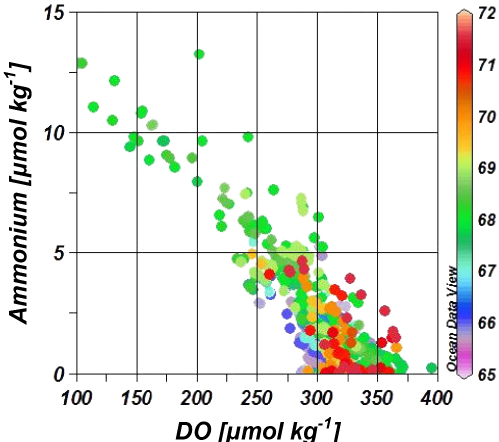
Figure 9. Diagram of dissolved oxygen (µmolkg − 1 ) and am- monium (µmolkg − 1 ) in the southern Chukchi Sea (65–72 ◦ N, 168 ◦ 45 (cid:48) W). Colour indicates latitude. Data were obtained from the late summer to autumn 2004, 2008, 2010, 2012, and 2013 R/V Mi- rai